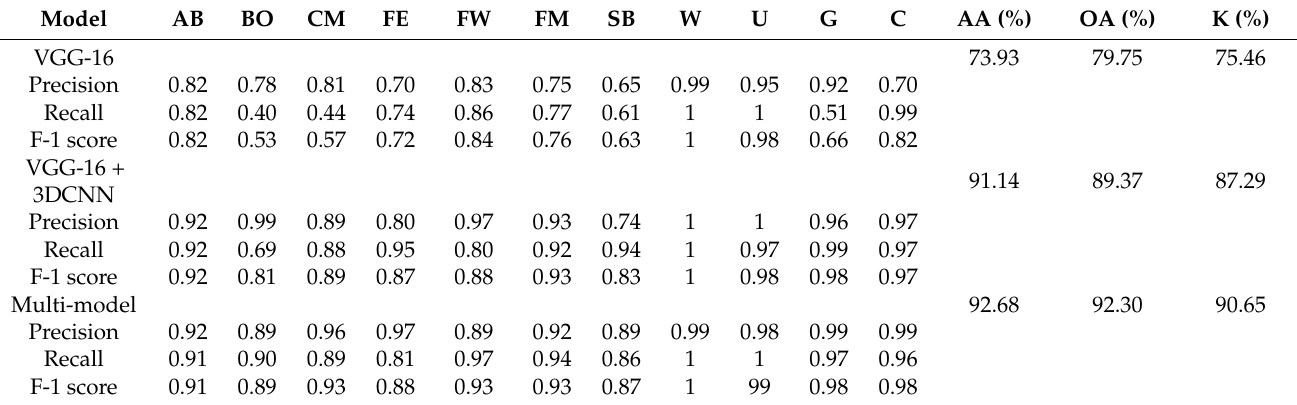
Table 4. Results of the proposed multi-model compared with other classifiers in terms of average accuracy, precision, F1-score, and recall (AB = aquatic bed, BO = bog, CM = coastal marsh, FE = fen, FM = freshwater marsh, FW = forested wetland, SB = shrub wetland, W = water, U = urban, G = grass, C = crop, AA = average accuracy, OA = overall accuracy, and K =